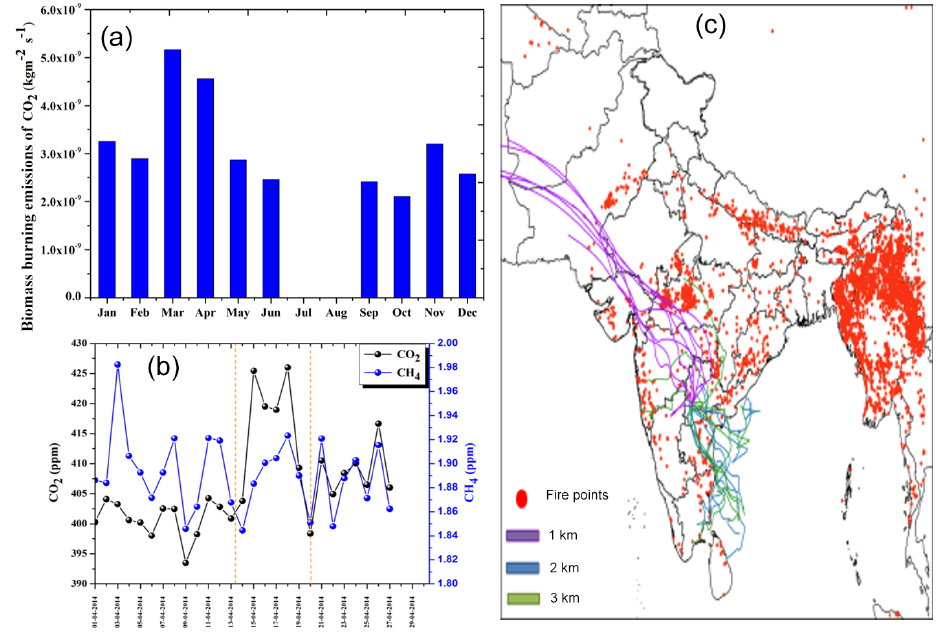
Figure 3. (a) Long term analysis of CO 2 biomass burning emissions over the study region; (b) biomass signatures on CO 2 / CH 4 during